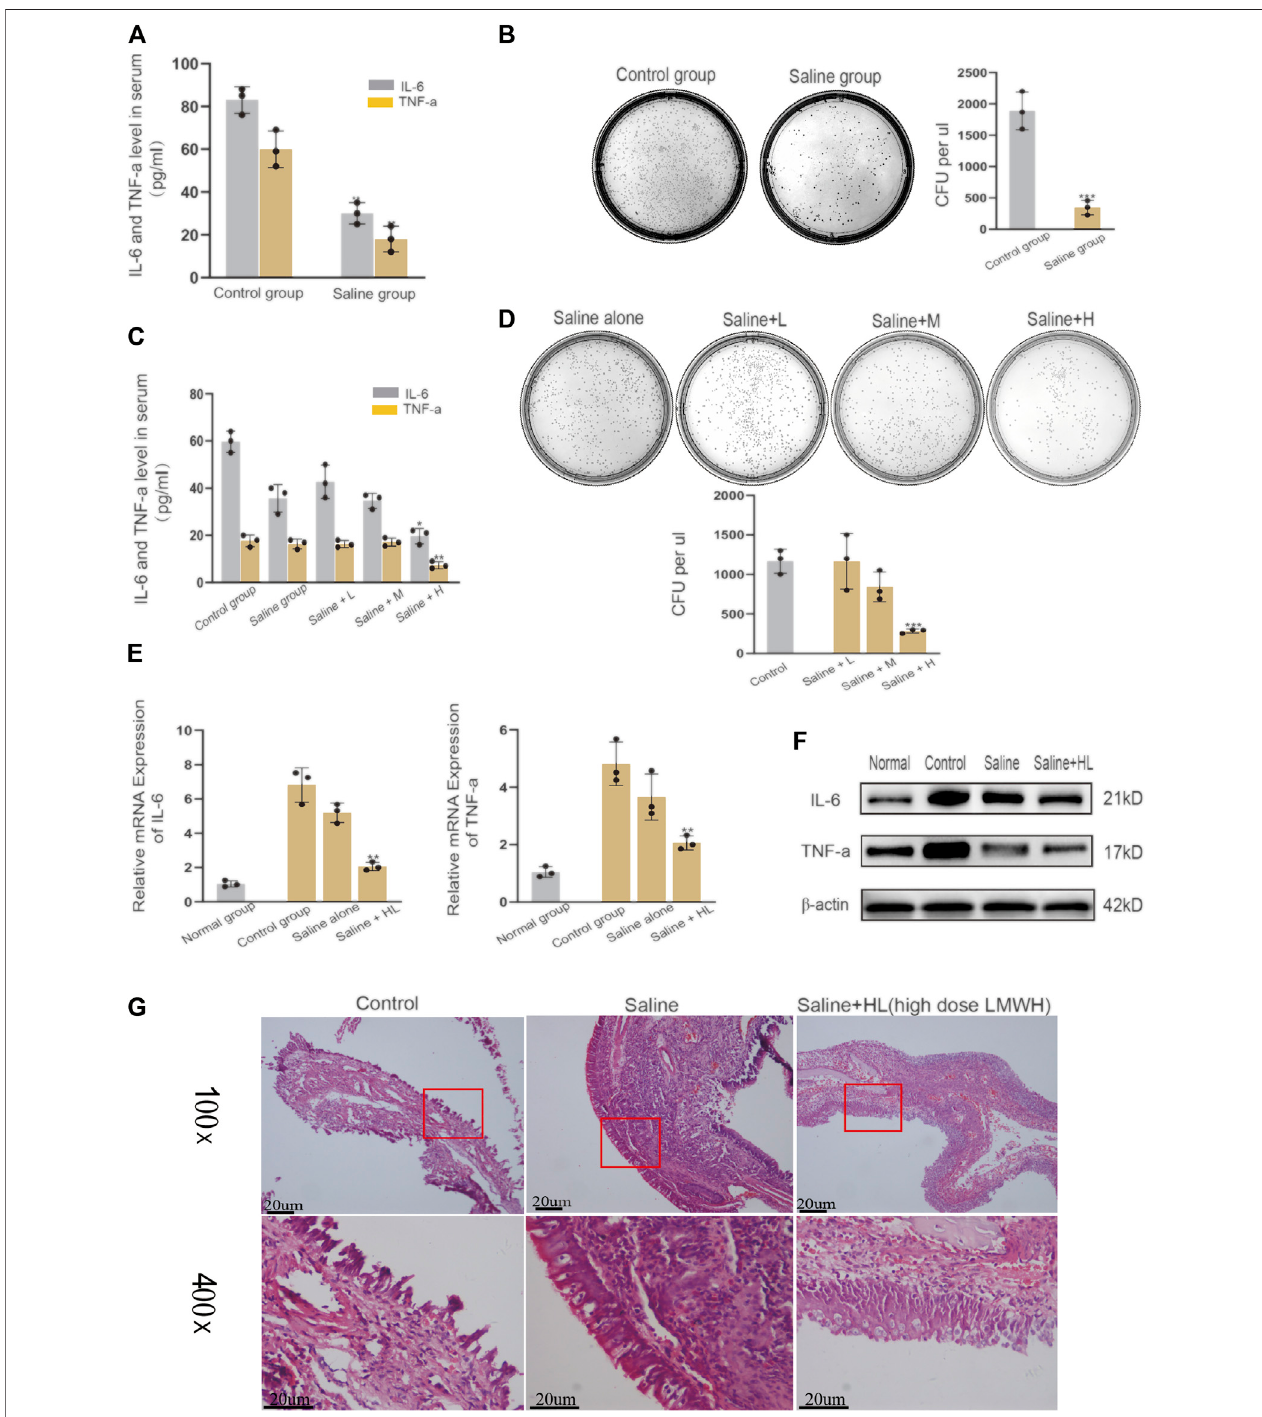
FIGURE3| EffectofnasalirrigationusingsalinemixedwithLWMHonacutesinusitisinrats. (A) SerumconcentrationsofTNF- α and IL-6inthenormalrats(withno treatment) and the saline group rats (nose cavity was irrigated with saline) were detected by ELISA. (B) Bacterial culture and comparison of colony number of sino-nasal lavagesampleintheexperimentalcontrolgroupandsalinegroups(nosecavitywasirrigatedwithsaline). (C) Serum concentrationsofTNF- α andIL-6inthesaline group rats (nose cavity was irrigated with saline) and the LMWH group rats (nose cavity was irrigated with saline mixed with different concentrations) were detected by ELISA. (D) Bacterial culture and comparison of colony number of sino-nasal lavage samples in the saline group and different concentrations of the LMWH group. (E) mRNAlevelofTNF- α andIL-6ofeachgroupwasdetectedbyquantitativeRT-PCR. (F) ProteinexpressionlevelsofratsofeachgroupweredeterminedbyWesternblot. (G) H&E staining results of nasal mucosa of rats in each group. Note: Saline + L (cid:1) Saline + low dose (75 u/kg) LMWH, Saline + M (cid:1) Saline + Medium dose (150 u/kg) LMWH, Saline + H (cid:1) Saline + high dose (300 u/kg) LMWH. *compared with control group p < 0.05; **compared with control group p < 0.01; ***compared with control group p < 0.001. The experiment was repeated three